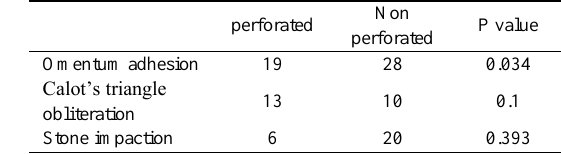
Table 4: Operative Findings with or Without Accidental Gallbladder